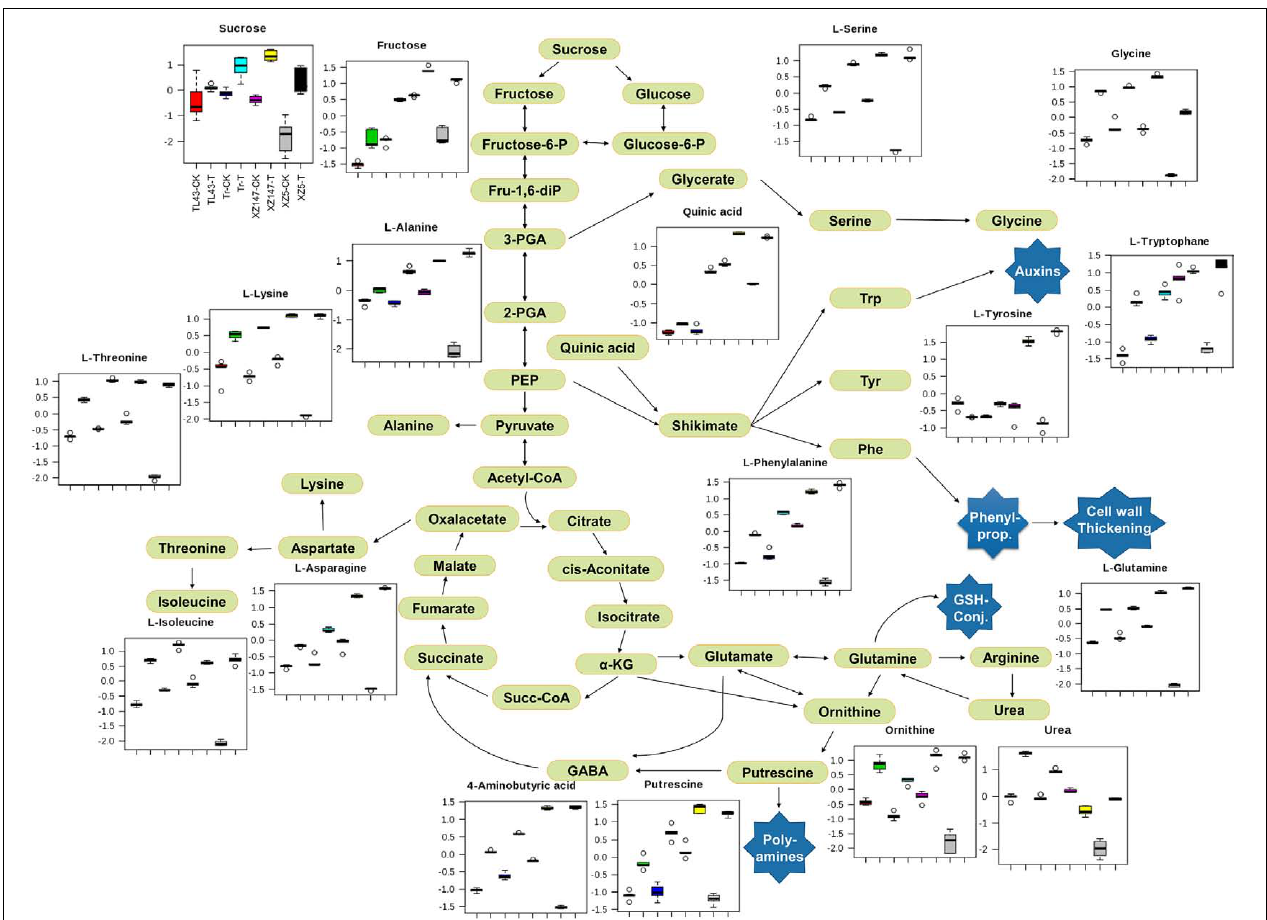
FIGURE 5 | Schematic overview of metabolic pathways in response to water treatments for different barley genotypes. CK, control condition with soil water content of 40%; T, water stress treatment with soil water content of 14%; and Tr, Triumph. Black arrows indicate specific metabolic